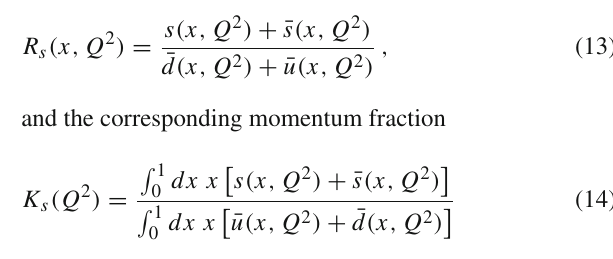
NucCor result from Fig. 13 for readability, as it is almost indistinguishable from the NucUnc